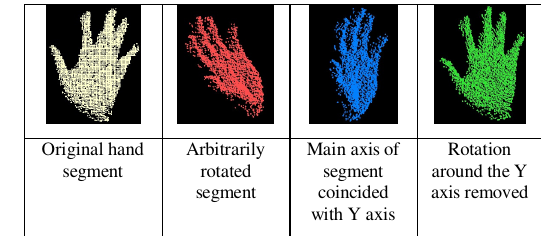
Figure 5. Example of rotation removal of a hand segment